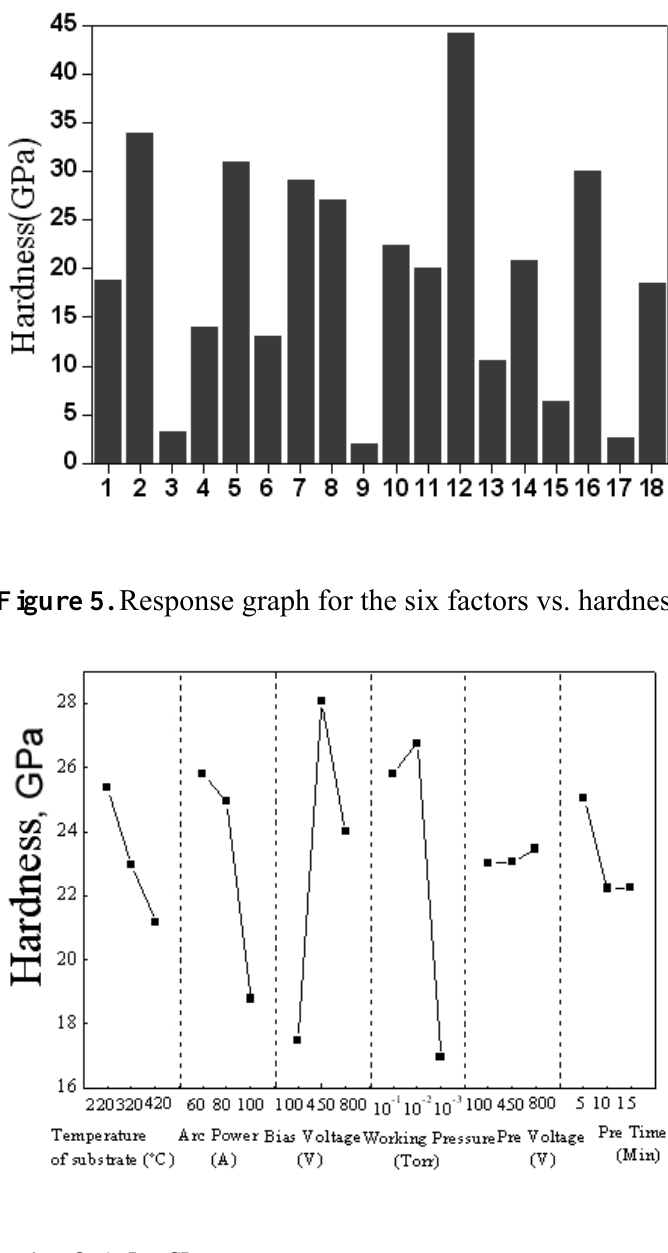
Figure 4. Average hardness of No. 1~18 samples.